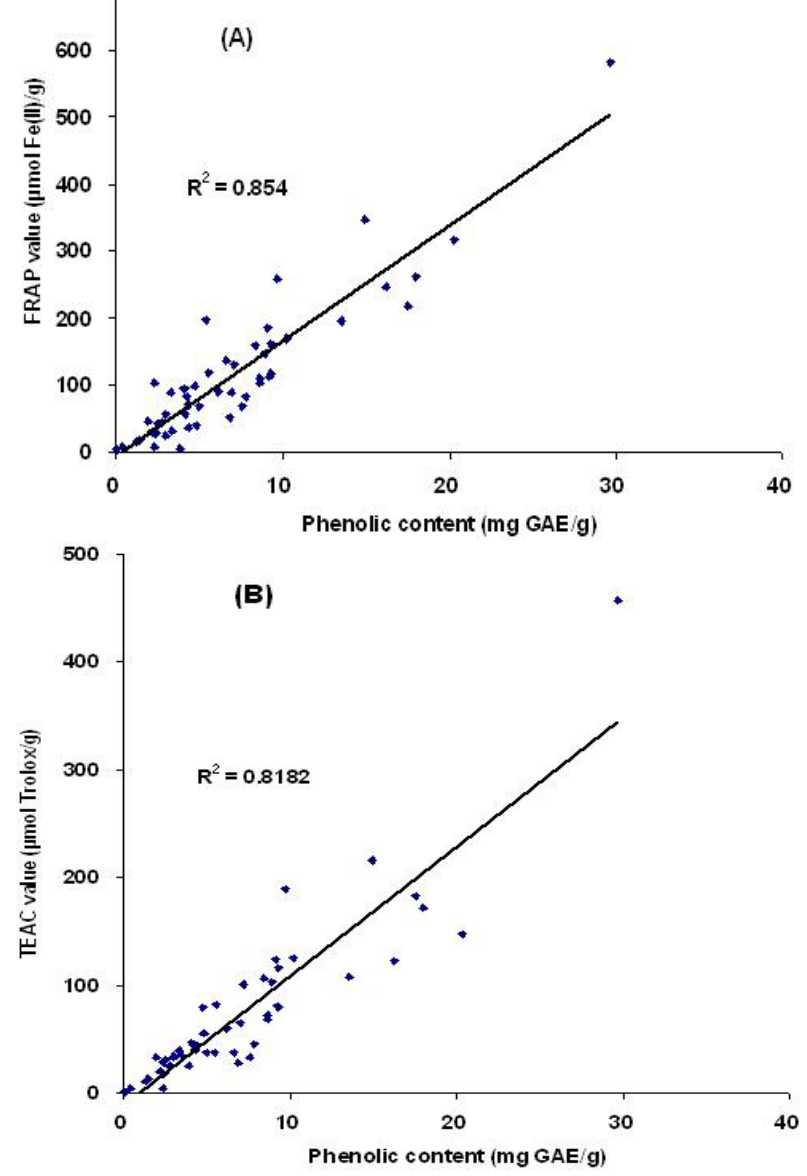
Figure 2. Correlation between the antioxidant capacities and total phenolic content. Antioxidant capacities were measured by the FRAP assay (A) and TEAC assay (B), respectively. GAE: gallic acid